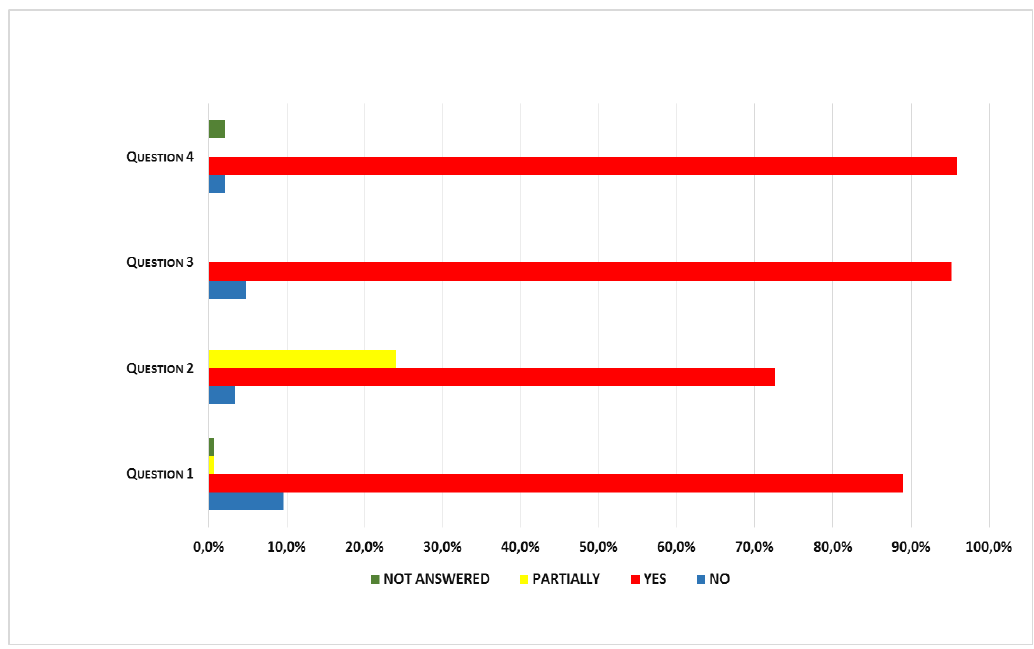
Figure 2. Results (% of answers) of satisfaction questionnaire submitted to participants.